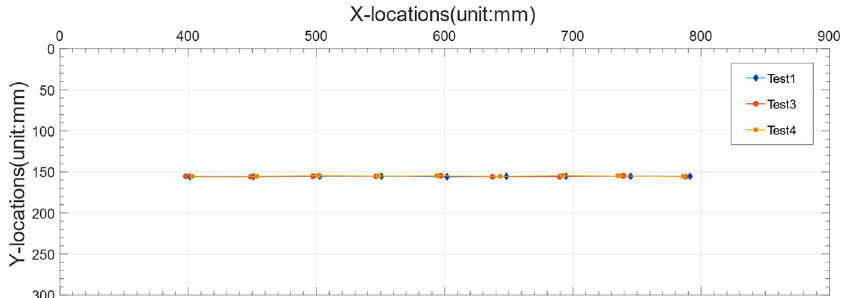
Figure 13. Trajectories of the model truck in Test 1, Test 3 and Test 4.